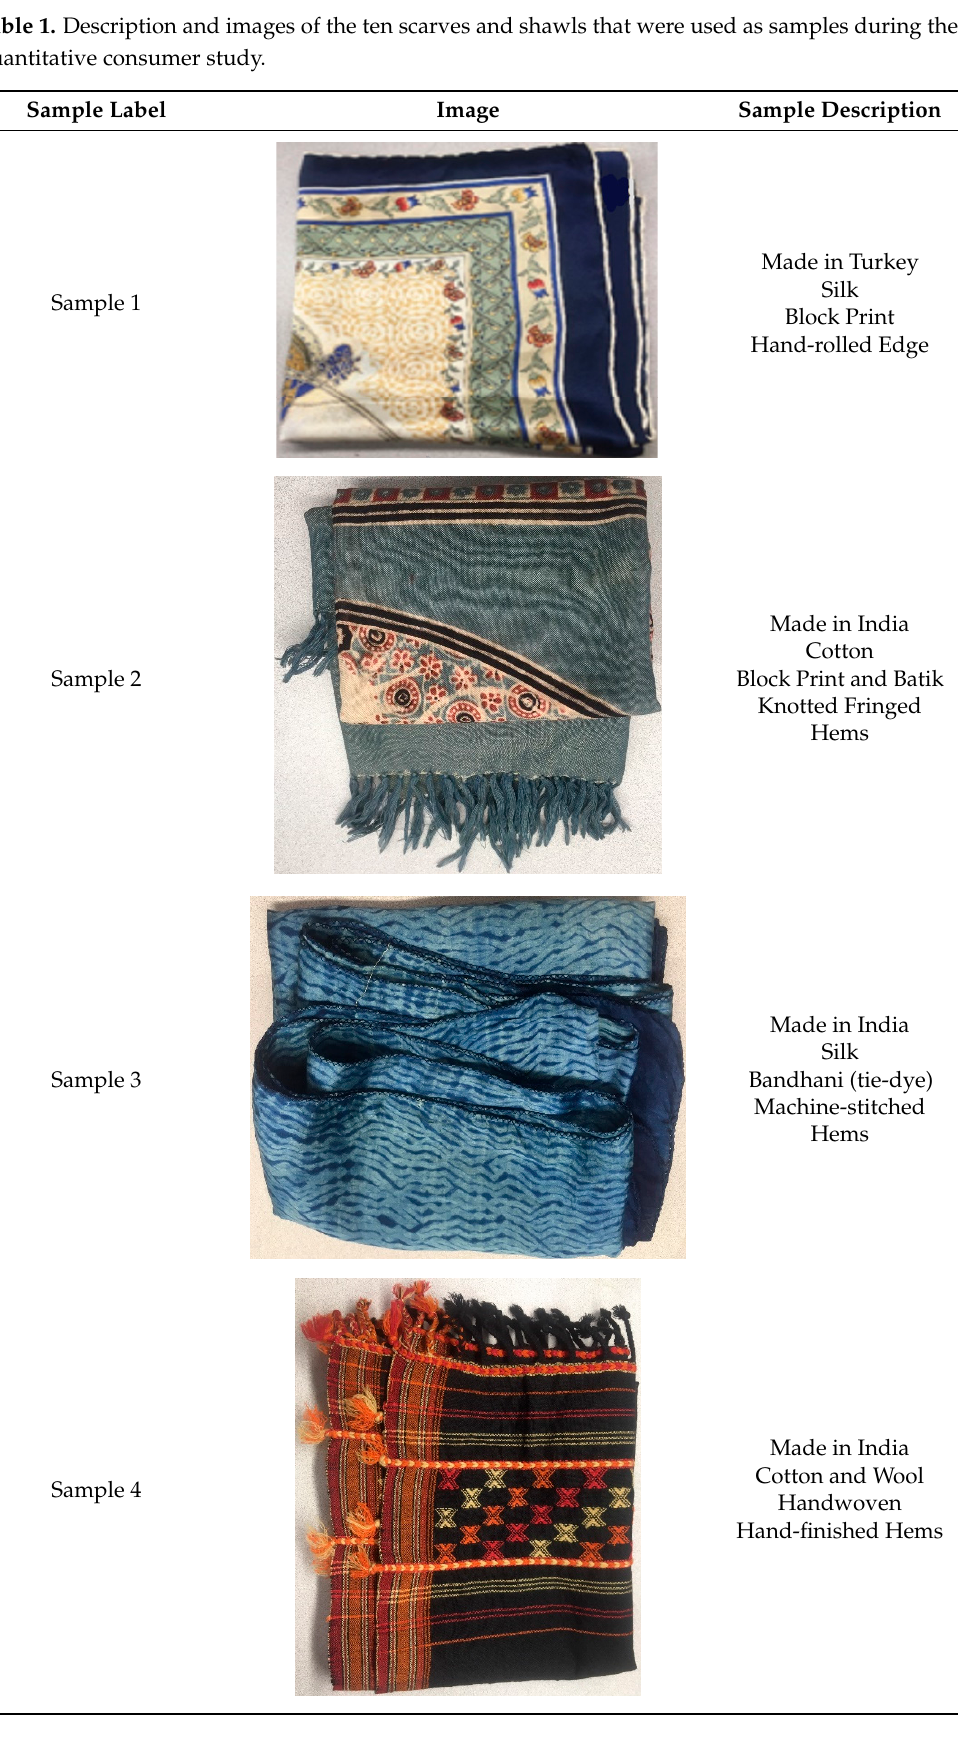
Table 1. Description and images of the ten scarves and shawls that were used as samples during the quantitative consumer study.